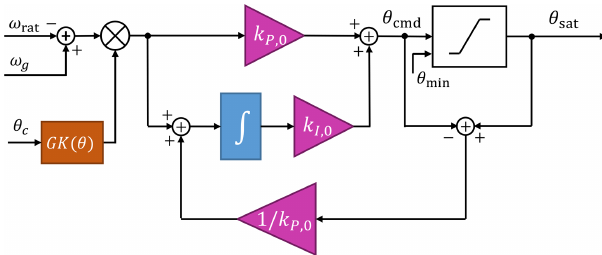
Figure A1. Proportional–integral control with antiwindup scheme used for above-rated control. The difference between the pitch con- trol set point ω rat and the generator speed ω g is multiplied with the gain-correction factor GK( θ avg ), which is a function of the current collective blade pitch θ c . The proportional–integral gains at zero pitch, k P, 0 and k I, 0 , are derived in Eqs. (A15) and (A16). The pitch command θ cmd is saturated to some minimum pitch setting θ min and the output θ sat is the input to the blade pitch